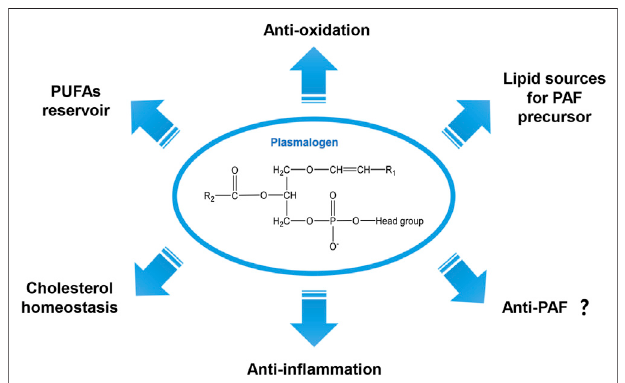
FIGURE 1 | General chemical structure of the vinyl-ether bonded plasmalogen lipid and its proposed biological functions.